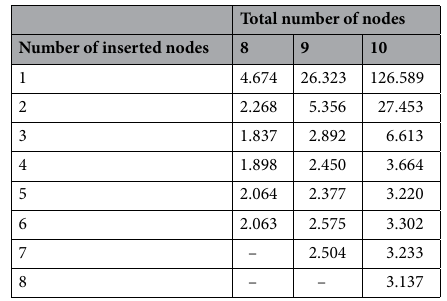
Table 5. Average time table of inserted node planning